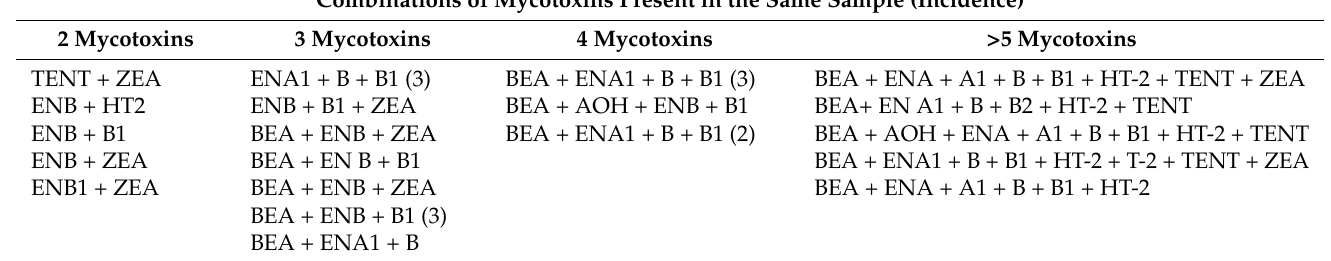
Table 5. Combinations of the co-present mycotoxins. the number of samples containing these combinations is indicated in